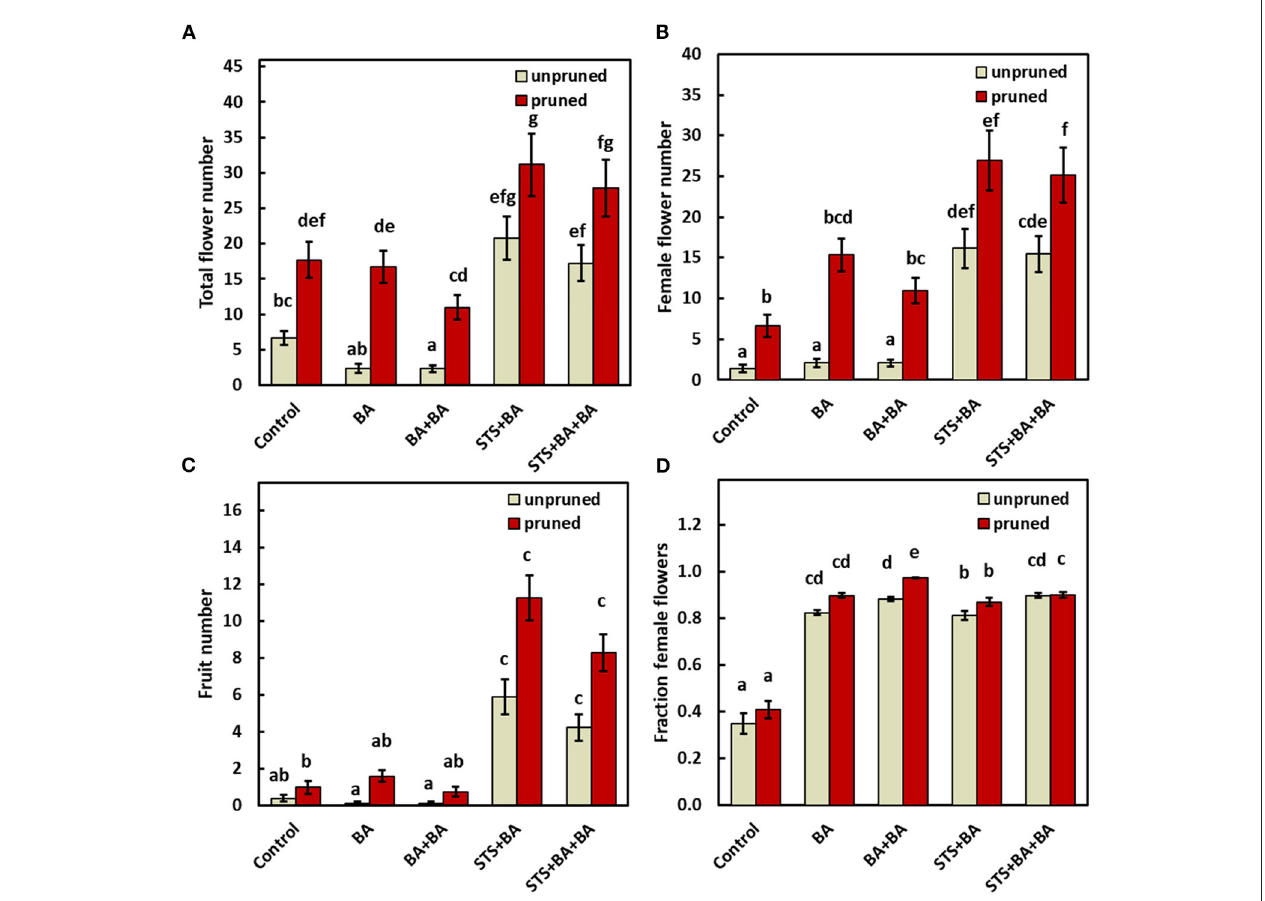
FIGURE 3 | The effect of PGRs and pruning on: (A) total flower numbers, (B) female flower numbers, (C) fruit numbers, and (D) proportion of female flowers (reflecting only plants with at least one flower). Data shown is the mean ± SEM of six replicate plots each of which contained the full set of genotype and treatment combinations, and with eight or four subplot plant replicates in 2018 and 2019, respectively. Treatments with different lowercase letters are significantly ( P < 0.05) different using Tukey’s HSD test. Comparisons and letter assignments were based on estimated marginal means (EMMs, least-squares means), as appropriate for statistical comparisons; arithmetic means and SEMs are plotted. PGR, plant growth